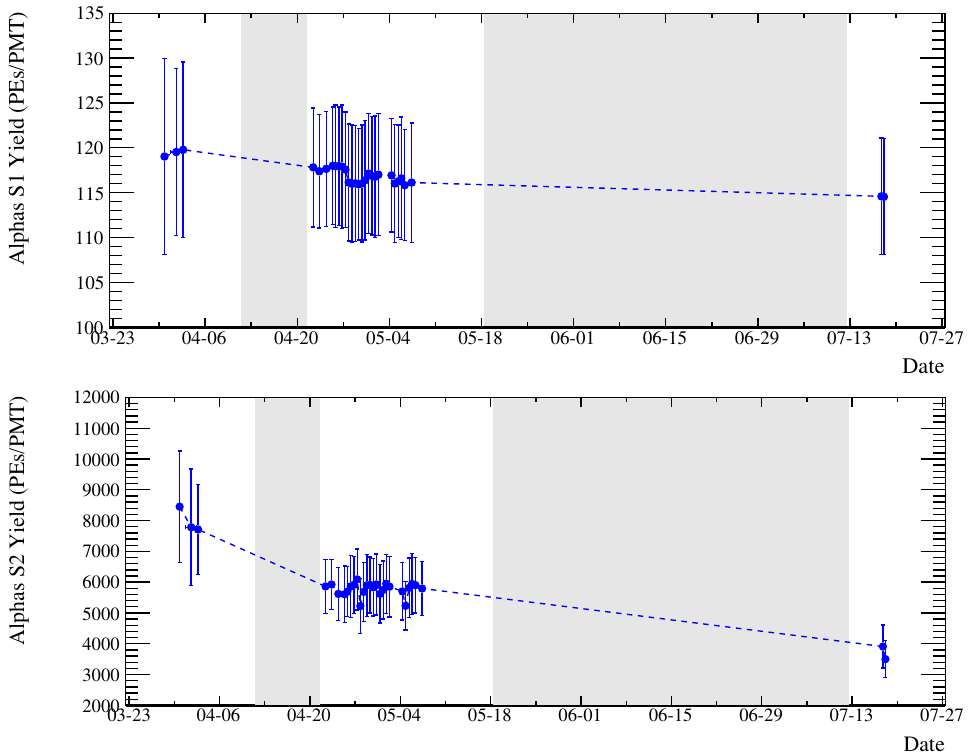
Figure 5 . S1 (top) and S2 (bottom) yields, corrected for the Z spatial dependence and for all (cid:12)ducial alpha events, during run periods A1{A3. The data points and error bars indicate the mean and the RMS of the Z -corrected distributions,